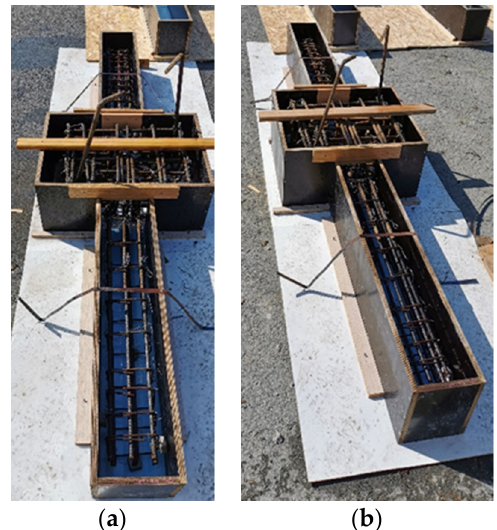
Figure 4. Specimens’ molds and steel reinforcement configuration: ( a ) with continuous longitudinal bars; ( b ) with lap-spliced bars.